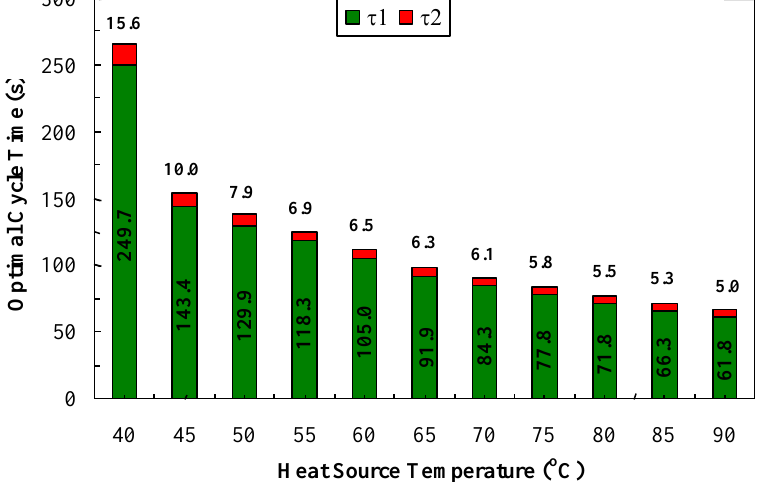
Figure 3. Optimal cycle time of the proposed cycle for different heat source temperature.